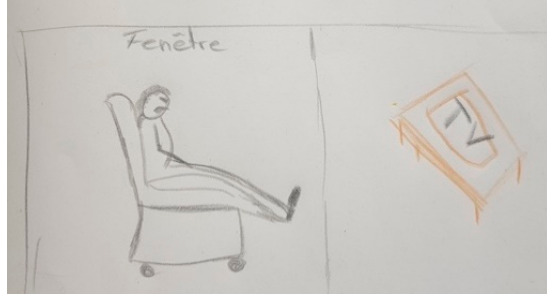
Figure 15. FC45’s perception of DBS’s effect.